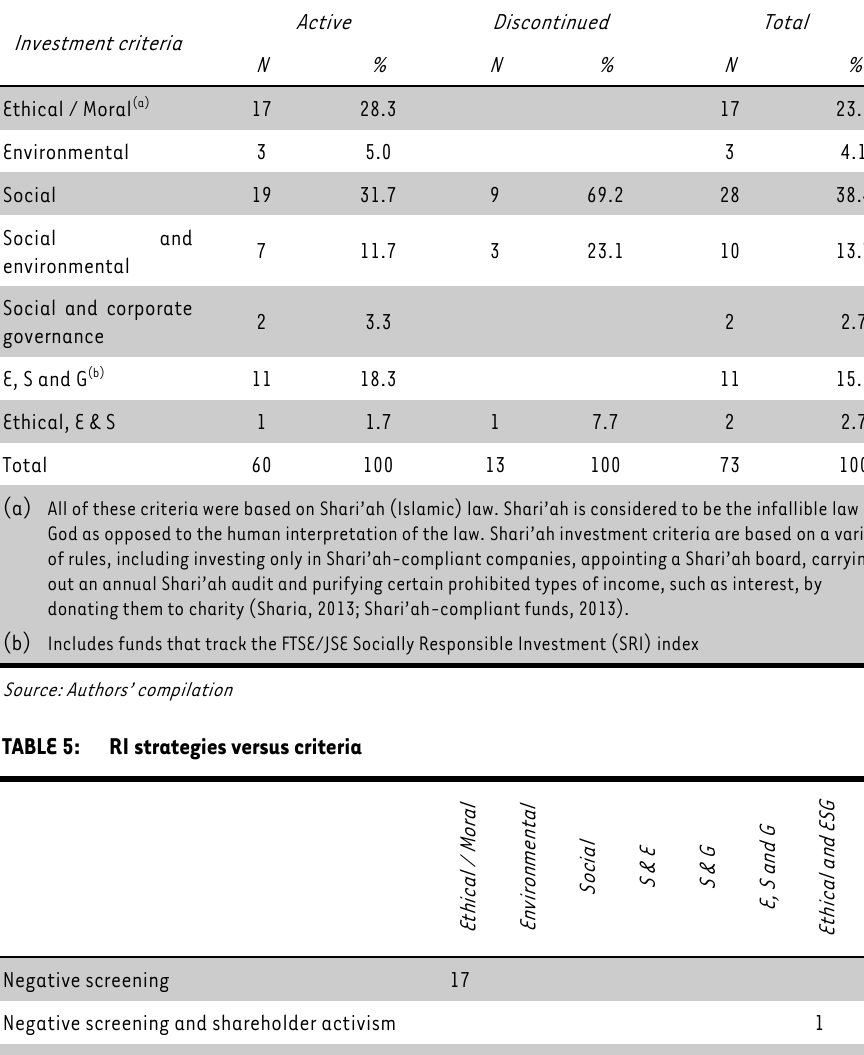
Negative screening Negative screening and shareholder activism Positive screening and shareholder activism Positive screening, shareholder activism and impact investing Positive screening, negative screening and